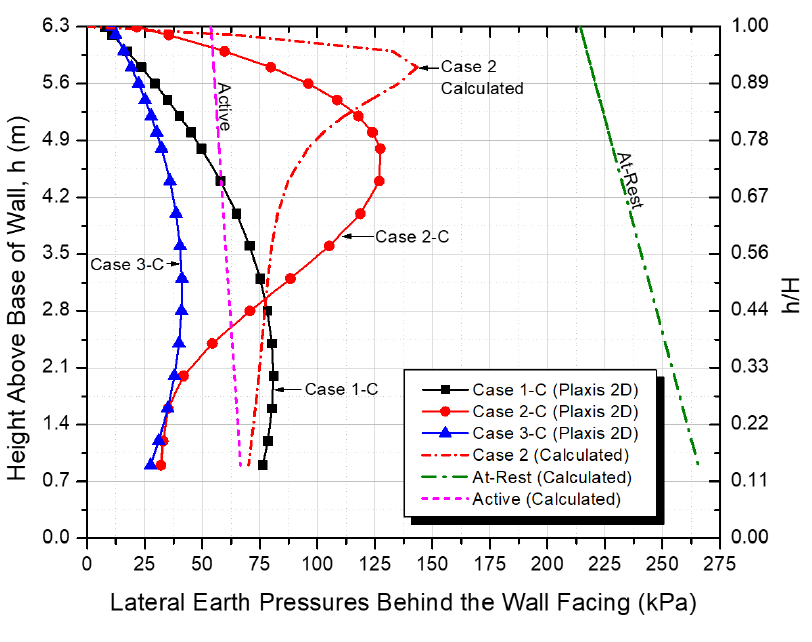
Figure 11. Lateral earth pressures behind the wall facing at: ( a ) Case 1A, 2A, and 3A (end of construction); ( b ) Case 1B, 2B, and 3B (general traffic loading); and ( c ) Case 1C, 2C, and 3C (railway loading).